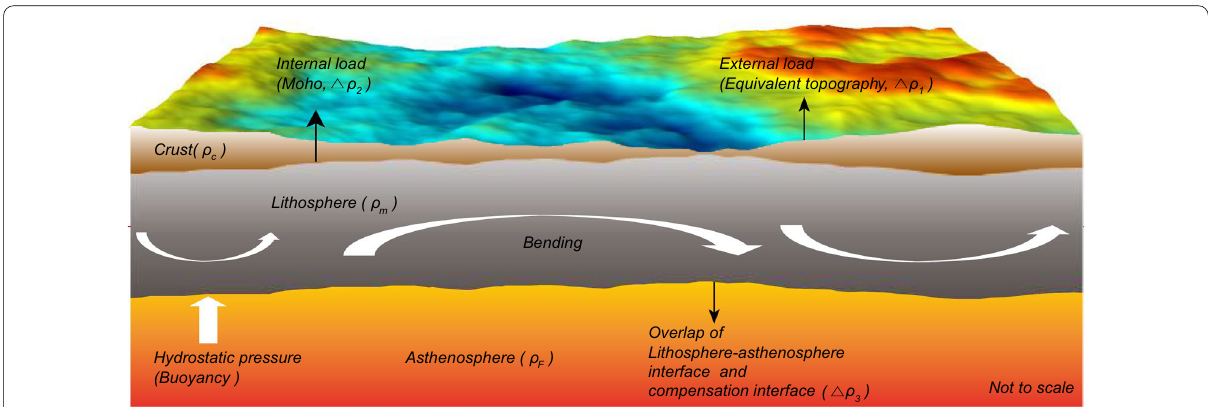
Fig. 1 Conceptual mechanical model of the lithosphere and asthenosphere, the compensation depth is set to be at the Lithosphere– asthenosphere interface (LAI). ρ c , ρ m and ρ F are density values (Table 1), and �ρ 1 = ρ c − ρ f , �ρ 2 = ρ m − ρ c , �ρ 3 = ρ F − ρ m are interface density contrasts, ρ f represents either the air density on land or seawater density in the ocean (revised from Banks et al.